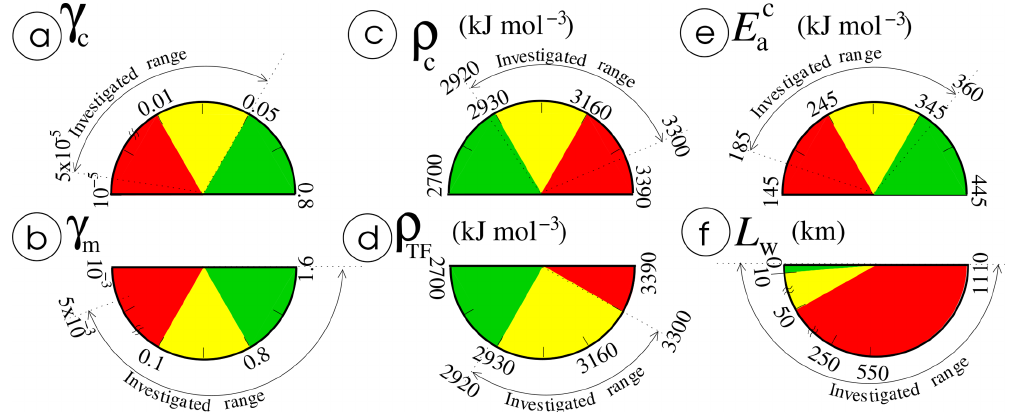
Figure 3. Physical properties tested in this study and investigated ranges. (a) Brittle parameter for the oceanic crust, γ c ; (b) Brittle parameter for the mantle, γ m ; (c) Oceanic crust density, ρ c ; (d) Density of the weak medium forming the TF, ρ TF ; (e) Activation energy of the oceanic crust, E c a , assuming a non-Newtonian exponent n = 3 in Eq. (4); (f) Lateral extent of the weak domain on both flanks of the TF, L w . The parameter intervals vary from realistic ranges (in green) to extreme values (in yellow). They are still extended beyond these values, up to unrealistic ranges to achieve the conditions allowing for spontaneous subduction (in